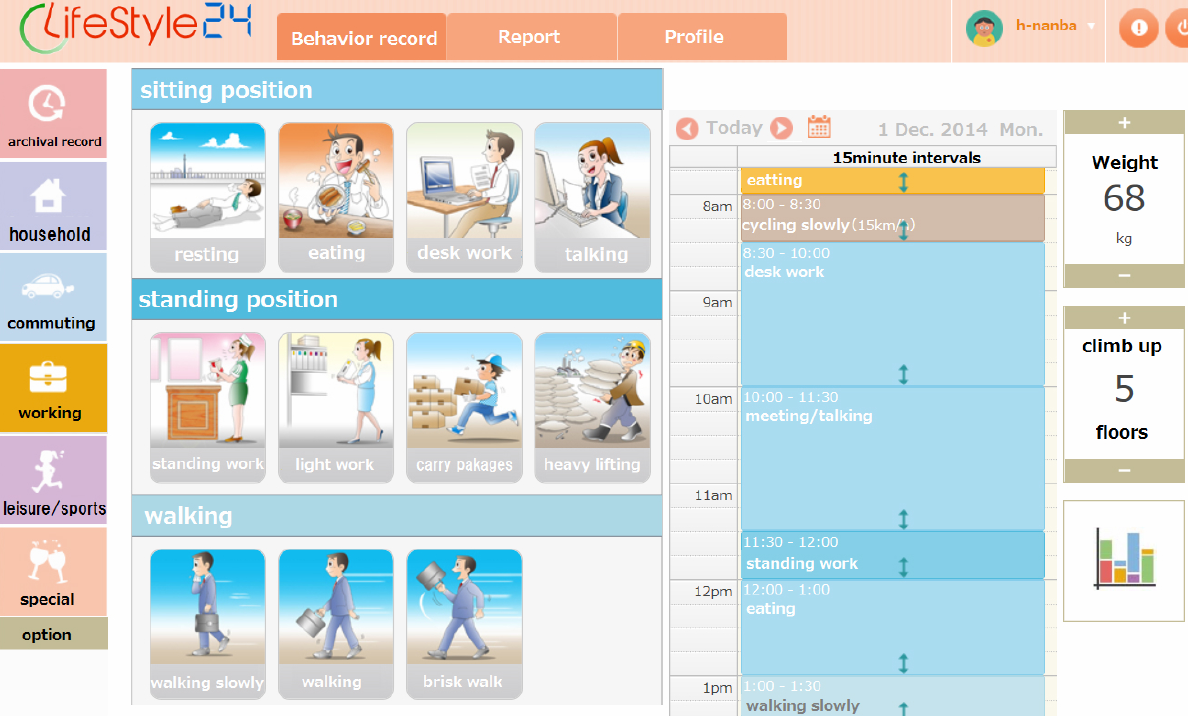
Figure 2. Equations for calculating mean metabolic equivalents (METS) and moderate-to-vigorous physical activity (MVPA) over a 24-hour